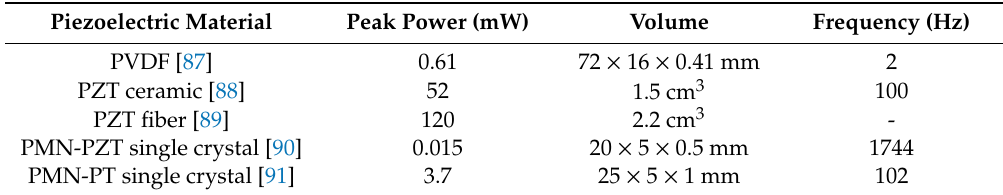
Table 4. Generated peak power for piezoelectric materials.